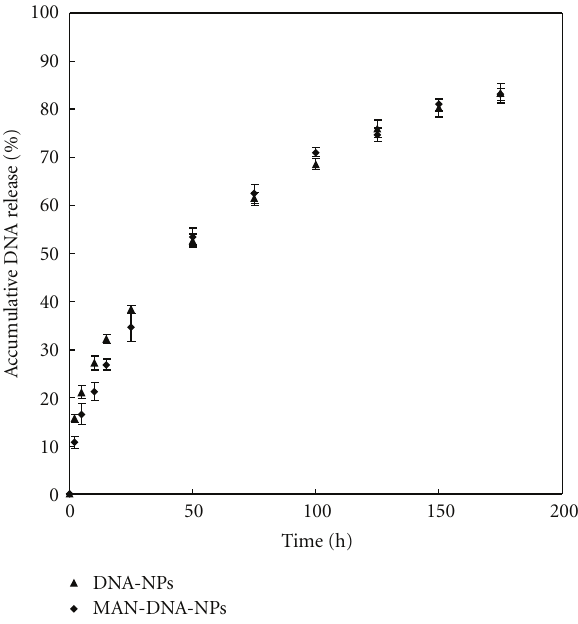
Figure 3: In vitro release profile of MAN-DNA-NPs and DNA-NPs (mean ± SD, n = 3).